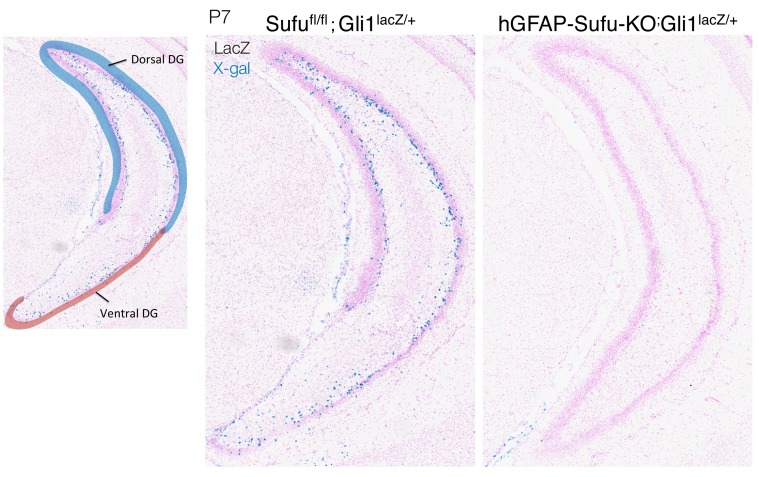
Deletion of Sufu decreases Hh-responding cells during DG development.Representative Gli1-LacZ staining images of dorsal DG in sagittal sections of Sufufl/fl;Gli1lacZ/+ and hGFAP-Sufu-KO;Gli1lacZ/+ mice. Note that lacZ +cells are observed more in dorsal DG compared with ventral DG, and these cells are diminished in both DGs in hGFAP-Sufu-KO;Gli1lacZ/+ mice.